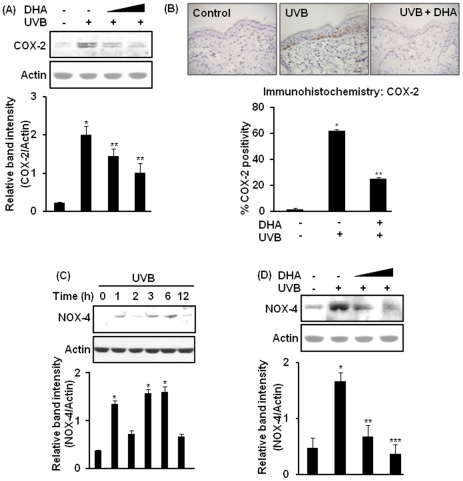
Inhibitory effects of DHA on UVB-induced expression of COX-2 and NOX-4 in mouse skin.Dorsal skin of female HR-1 hairless mice (n = 3 per treatment group) were treated topically with DHA (2.5 or 10 µmol/mouse) dissolved in 0.2 ml acetone 40 min before UVB (180 mJ/cm2) irradiation, and sacrificed after 6 h. Control animals were treated with acetone and left unirradiated. (A) Epidermal lysates were analyzed for COX-2 expression by immunoblotting. *,
p<0.001 (control versus UVB); **,
p<0.01 (UVB only versus 2.5 or 10 µmol DHA plus UVB). (B) Skin samples from mice treated as above were subjected to immunohistochemical analysis by using affinity purified murine COX-2 antibody as described in Materials and Methods. Positive COX-2 staining yielded a brown-colored product: acetone (left), UVB alone (middle), and UVB plus 10 µmol DHA (right). Percent of COX-2 positivity was calculated as the ratio of number of COX-2-stained cells to total number of epidermal cells counted from 10 equal sections of immunostained tissues from each animal. *,
p<0.001 (control versus UVB); **,
p<0.01(UVB versus 10 µmol DHA plus UVB). (C) Dorsal skin was irradiated with UVB and animals were sacrificed at indicated time periods for assessing NOX-4 expression. *,
p<0.001 (control versus UVB). (D) Mice were treated with DHA and irradiated with UVB as indicated above and epidermal NOX-4 expression was examined by immunoblotting. *,
p<0.001 (control versus UVB); **,
p<0.01 (UVB alone versus 2.5 µmol DHA plus UVB); ***,
p<0.001 (UVB alone versus 10 µmol DHA plus UVB).